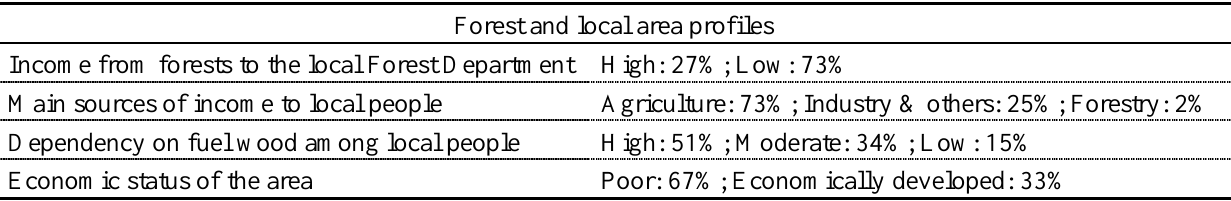
Table 2. Status of forests and local area conditions in the respondents’ work places ( N =